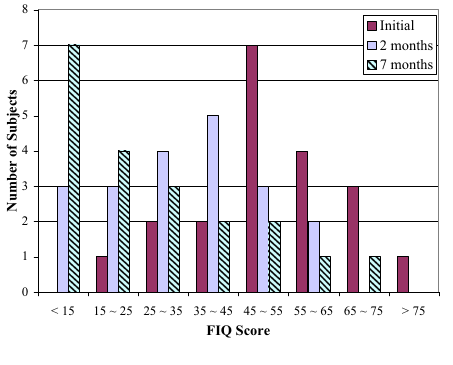
Figure 1 Histogram of total fibromyalgia impact questionnaire (FIQ) score. The number of subjects (n = 20 at each time point) with scores in each range is shown for 0, 2, and 7 months of dietary intervention. Increasing score denotes a greater nega- tive impact of FMS on the